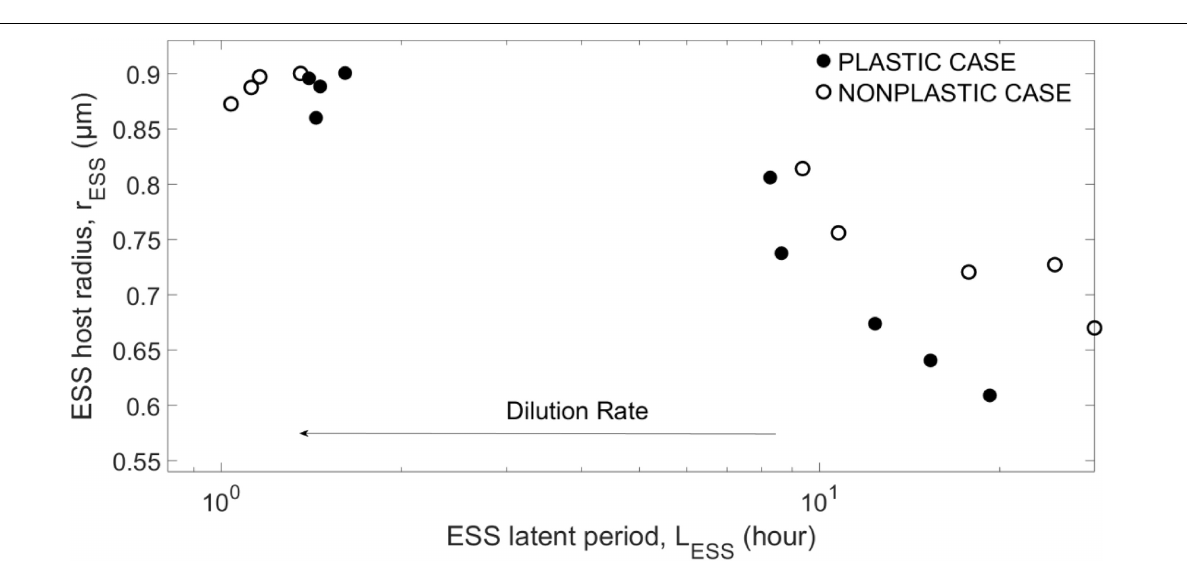
FIGURE 3 | Evolutionary stable strategies (ESS) for the host and virus obtained for N 0 = 10 − 5 mol l − 1 and α = 10 x 10 − 9 l cell − 1 d − 1 , and different dilution